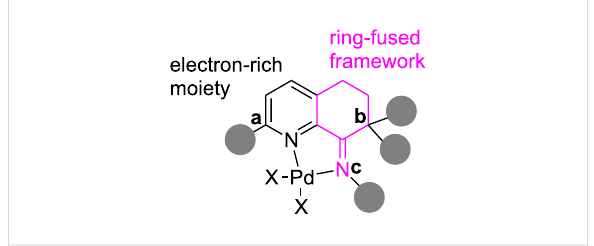
Figure 1: The steric geometry-constrained iminopyridyl–palladium complexes.